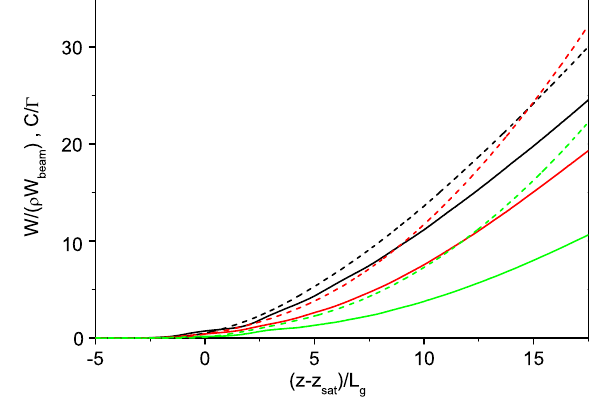
3. Evolution along the undulator of the reduced radiation Þ (solid curves) and of the detuning power ˆ η ¼ W= ð ρ W beam ˆ C ¼ C= Γ (dashed curves) for the FEL amplifier with parameter global optimization of the undulator tapering. Color codes: black, red, green curves correspond to the value of diffraction parameter B ¼ 1 , 10, and 40.